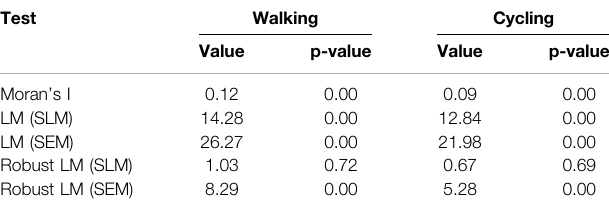
TABLE 5 | Results of the Lagrange multiplier (LM) test for walking and cycling. Test